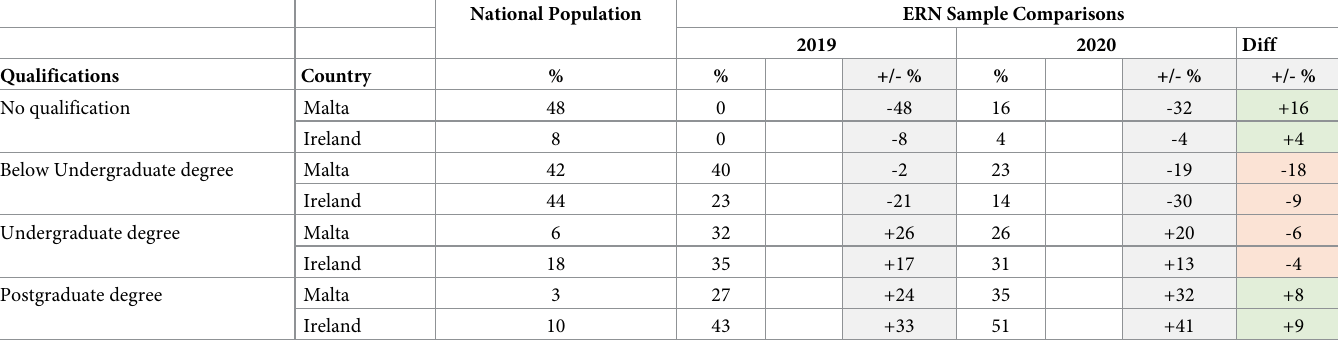
Table 5. Comparison of educational attainment of the national population and participating ERN audiences in 2019 & 2020.